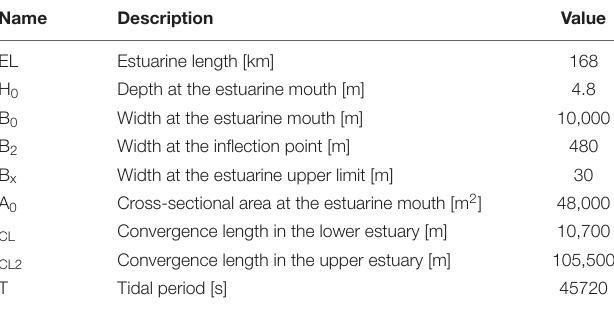
TABLE 1 | Geometrical and hydrodynamic parameters in the idealized geometry of the Seine estuary.